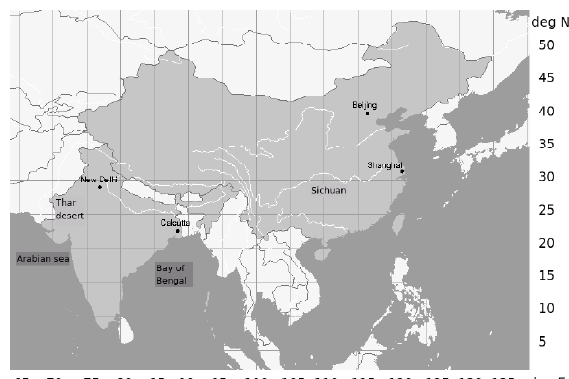
Fig. 1. Map of South and East Asia including India and China. Results presented for India are averages over the area 5–35 ◦ N × 65–90 ◦ E and results for China are averages over the areas 20–45 ◦ N × 95–125 ◦ E and 35–45 ◦ N × 75–95 ◦